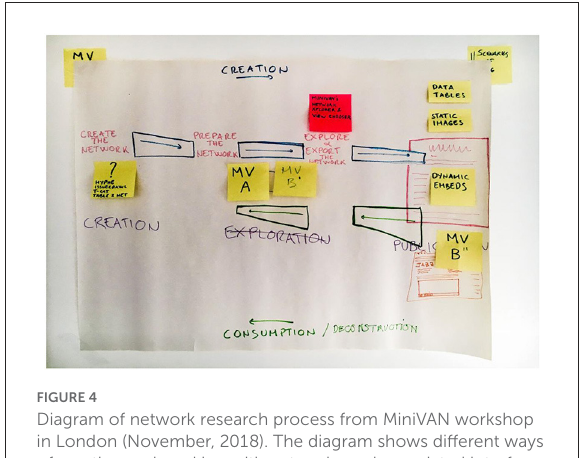
FIGURE4 Diagram of network research process from MiniVAN workshop in London (November, 2018). The diagram shows different ways of creating and working with networks and associated interface